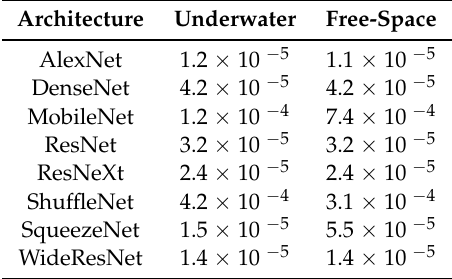
Table 3. Final learning rates for architectures in underwater and free-space data sets.